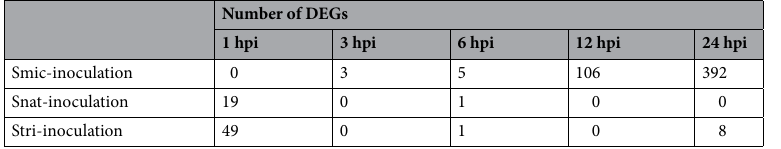
Table 1. Summary of DEG profiles of Symbiodinium -inoculated A. tenuis larvae at 1, 3, 6, 12, and 24 hpi. Gene expression levels were compared between Symbiodinium -exposed and unexposed groups, and genes exhibiting